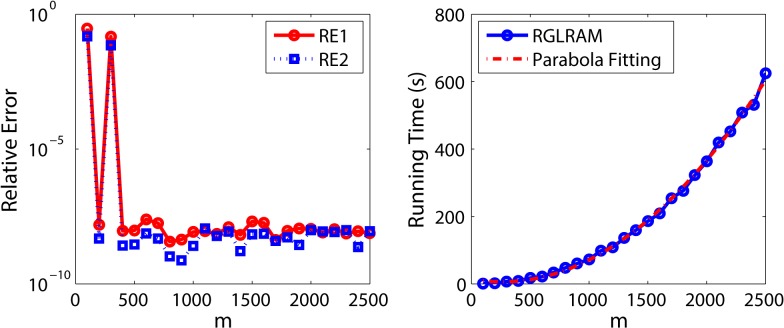
Experimental results of RGLRAM with different m.The left represents the relative errors with different m and the right represents the running time with different m.